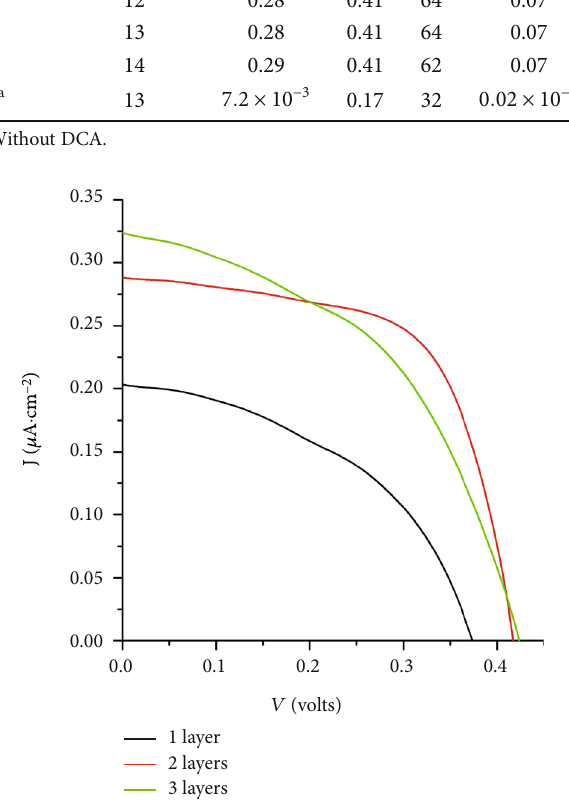
fi lm thicknesses 2